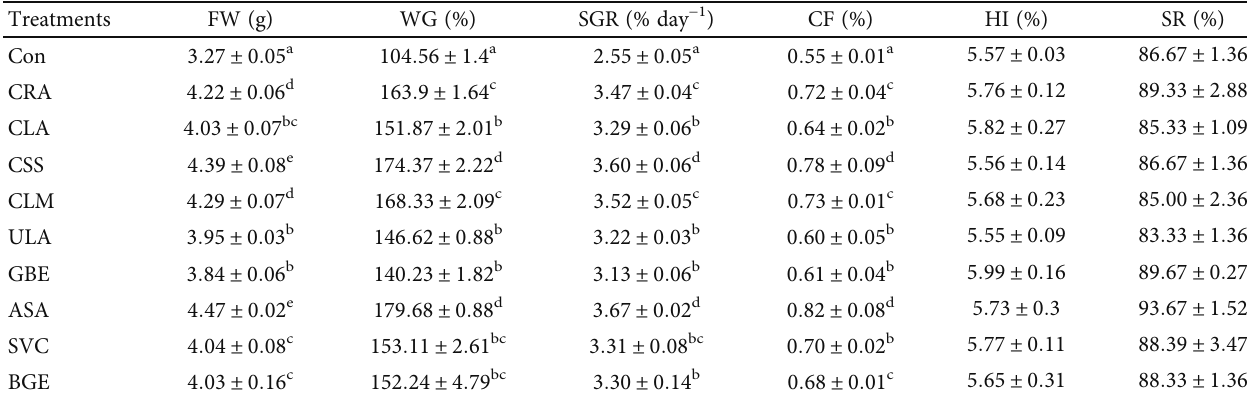
Table 3: E ff ect of macroalgae diet on growth performance in L. vannamei